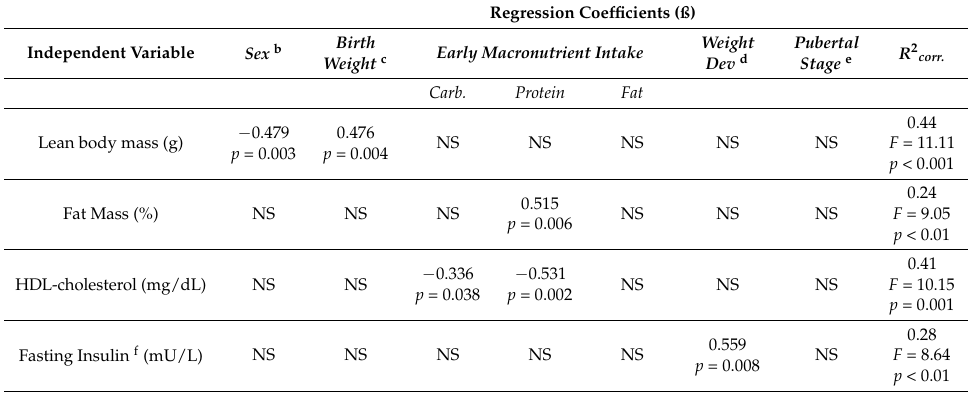
Table 2. Stepwise linear regression analyses of body composition and metabolic parameters in former ELBW infants at 9.5 years of age ( n = 30).